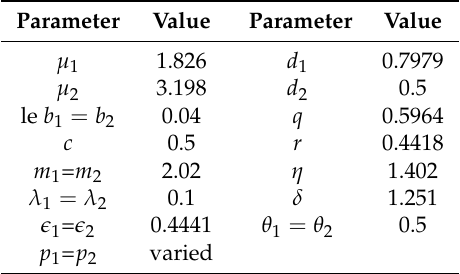
Table 2. The values of the parameters of the model in Equations (19)–(23). Parameter